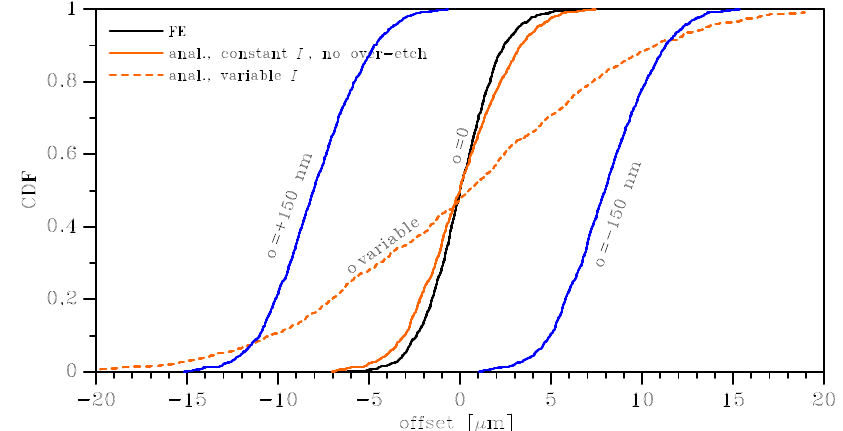
Figure 12. Effect on the offset of the variable (over-etch affected) moment of inertia I and Young’s modulus along the beam length (200 × 2 µ m 2 case, uniform strain BCs). Blue lines refer to fixed values for the over-etch equal to ± 150